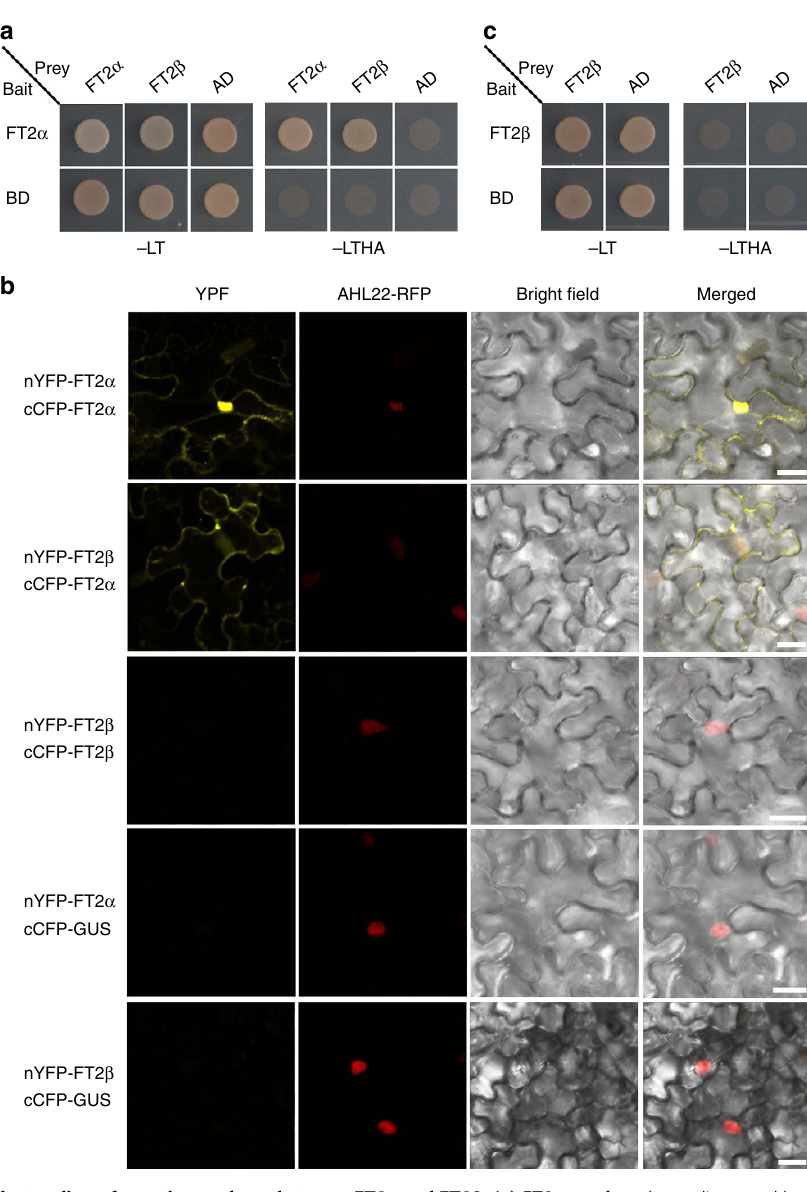
Figure 4 | Homodimer and heterodimer formation analyses between FT2 a and FT2 b . ( a ) FT2 a can form homodimer and heterodimer with FT2 b in yeast cells. ( b ) BiFC assays for FT2 a and FT2 b homodimer and heterodimer formation determination. GUS was used as a control in the absence of FT2 a or FT2 b . Scale bar, 20 m m. ( c ) FT2 b cannot form homodimer in yeast cells. Yeast cell growth on selective media without Leu, Trp, His and Ade ( (cid:2) LTHA) indicates positive